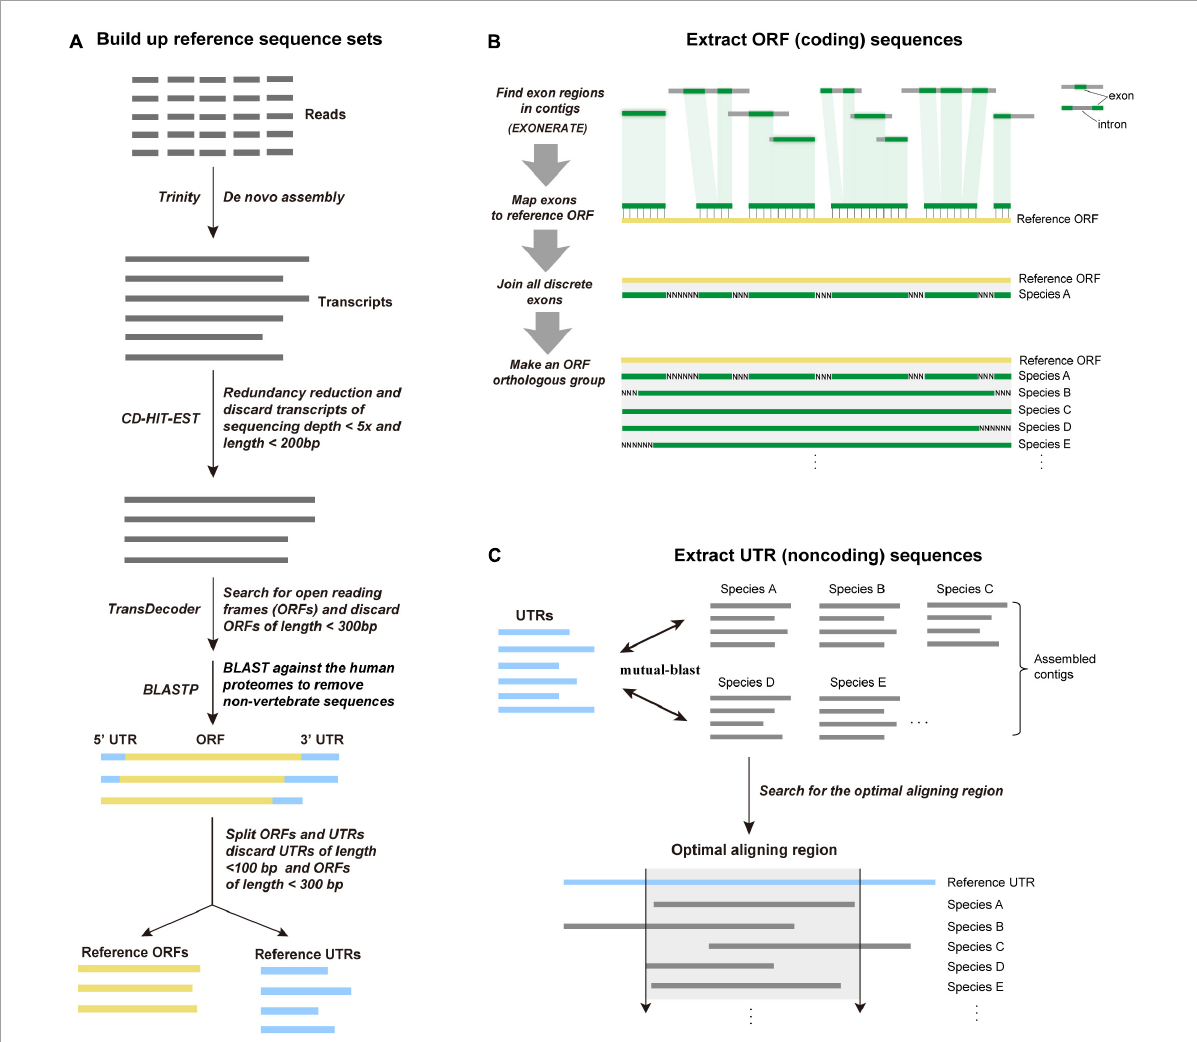
FIGURE2 Details of the FLc-Capture data processing. (A) Creating reference ORF and UTR sets by sequencing the cDNA probes. (B) Extracting ORF (coding) sequences. First, FLc-Capture assembles reads into contigs, and identifies exons from contigs using EXONERATE based on the reference ORF sets. The identified exons are then mapped onto the reference ORF sequences to make the orthologous ORF sequences, based on the position information resulted from the EXONERATE searches. (C) Extracting UTR (non-coding) sequences. Based on the reference UTRs, FLc-Capture uses a mutual best-hit (MBH) strategy to identify orthologous UTR sequences and truncate the sequences according to the optimal aligning